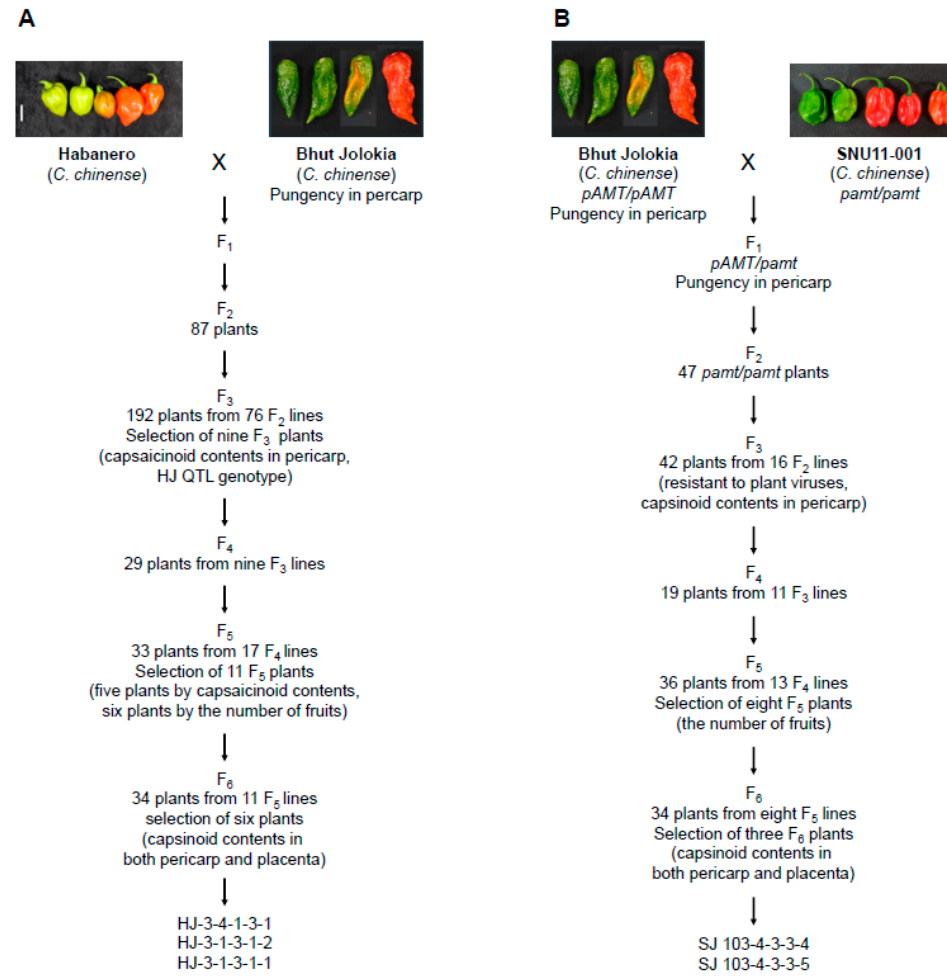
Figure 1. Diagram of the novel Capsicum variety breeding program. ( A ) Selection of highly pungent lines from the ‘HB’ × ‘BJ’ population, ‘HJ’. ( B ) Selection of lines containing high levels of capsinoids from the ‘SNU11–001’ × ‘BJ’ population,